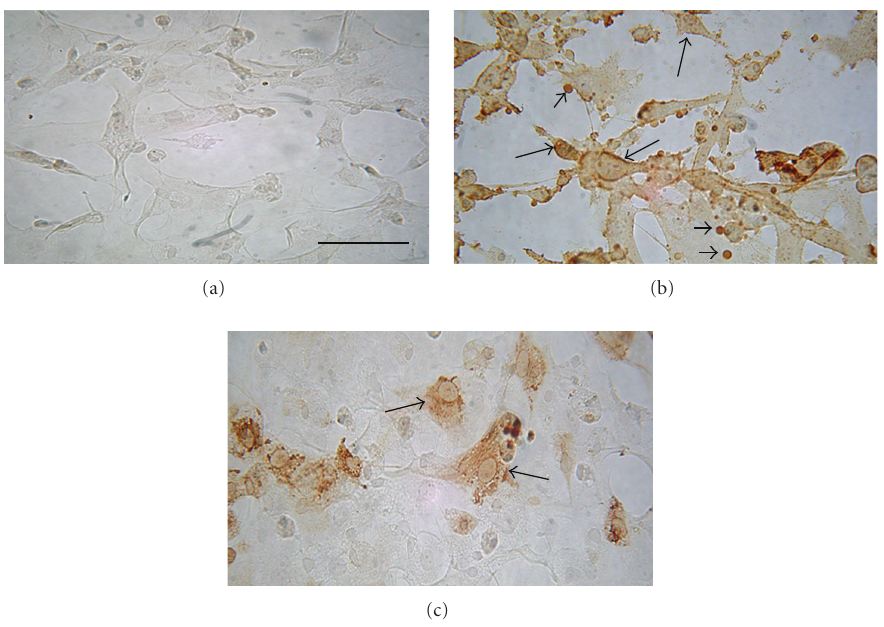
Figure 3: Immunocytochemistry for DENV2-infected or noninfected macrophages. (a) Noninfected macrophage control. (b) Macrophages from DENV-infected BALB/c mice at 1MOI, 72 hours p.i. Observe the staining in almost all cells (arrows). Note the extracellular vesicles immunoreactive to viral antigen (arrow heads). (c) Hamster macrophages DENV-infected at MOI 1, 72 hours p.i. The stained cells show an intracytoplasmatic viral antigen distribution; the other animals showed a similar labelling pattern. The bars correspond to 40 μ